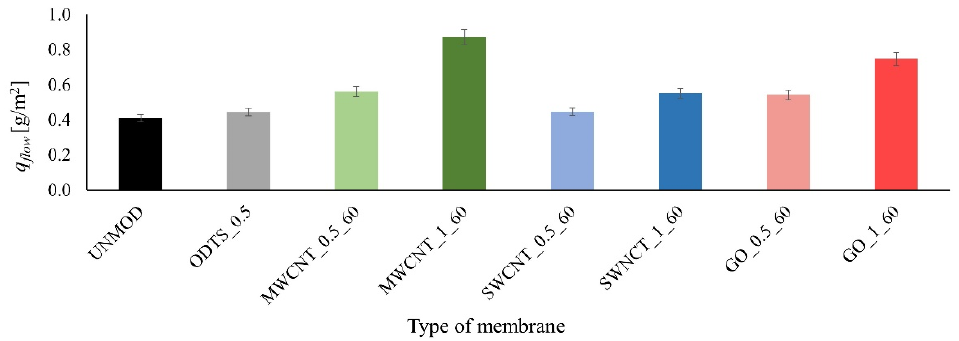
Figure 6. Mass of the tetracycline removed from water in the flow-through system.